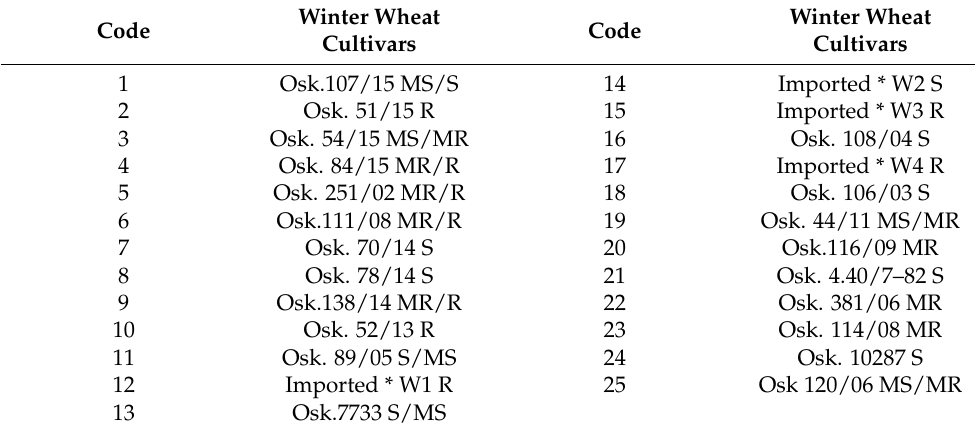
Table 1. Code names of tested winter wheat cultivars with different resistance levels to FHB used in tables and figures. Letters indicate cultivars’ resistance to Fusarium infection: R—resistant, MR—moderately resistant, MS—moderately susceptible, S—Susceptible. Winter Wheat Code Cultivars